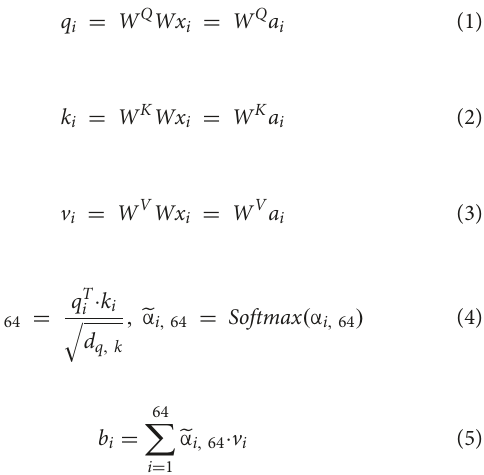
As illustrated by Figure 2 . The Swin Transformer backbone network has four stages corresponding to four feature maps of different sizes. The feature map sizes are H/4 × W/4 × C, H/8 × W/8 × 2C, H/16 × W/16 × 4C, H/32 × W/32 × 8C. The feature map of